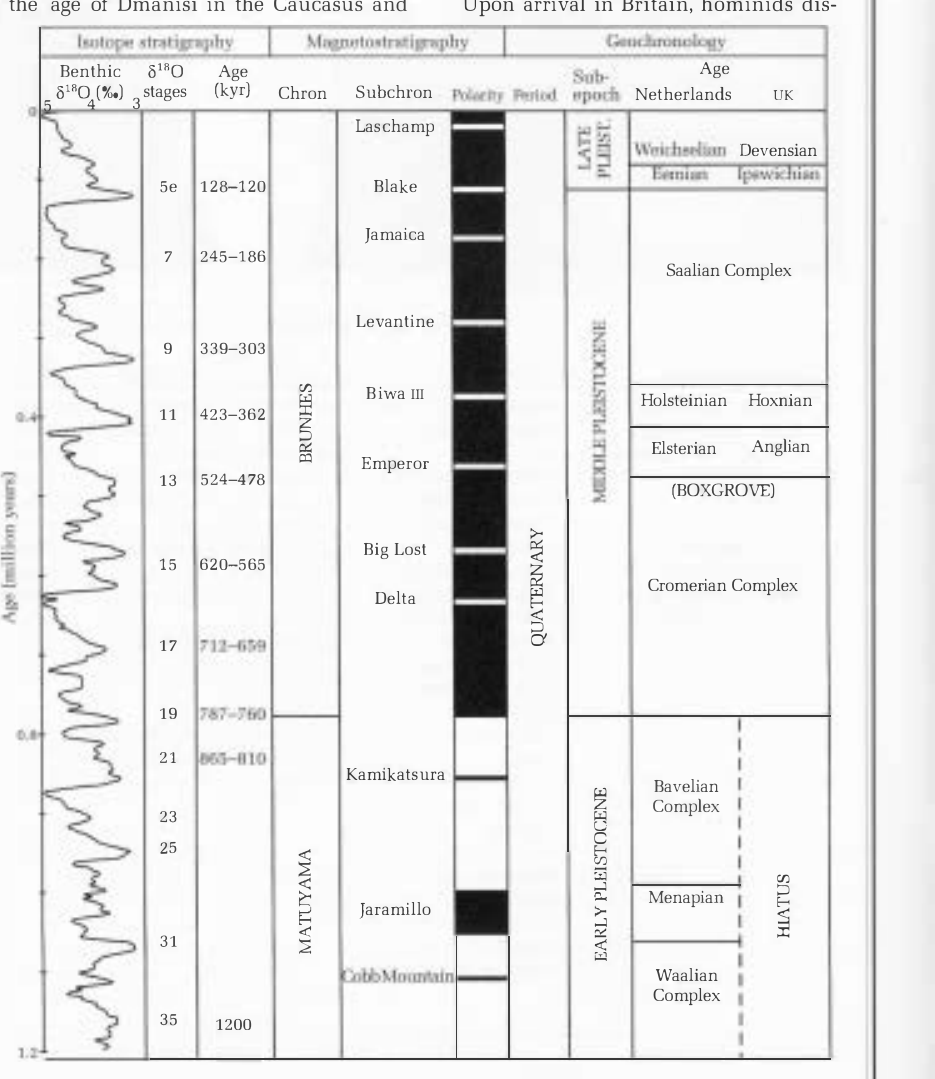
Figure 1 Chart of the last 1 .2 million years of the Quaternary Period, based on isotope stratigraphy from deep ocean cores, magnetostratigraphy showing normal (black) and reversed {white) polarity, and geochronology. The position (age) of the Boxgrove tem­ perate sediments is shown in the right-hand column.